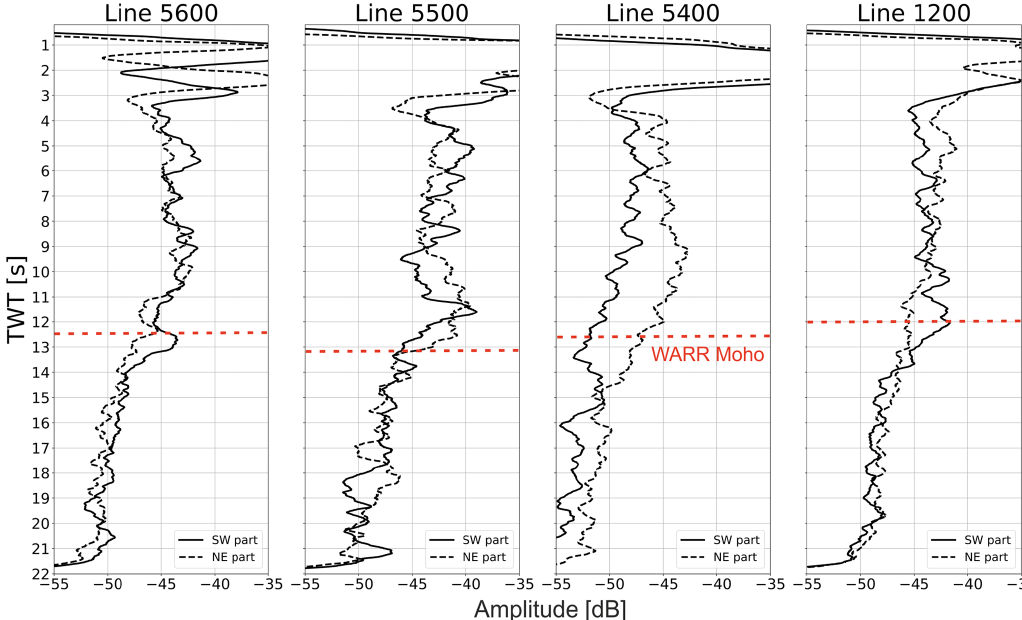
Figure 6. Amplitude decay curves extracted from the sections shown in Figs. 4 and 5. Red dashed line indicates average Moho depth inferred from WARR data.